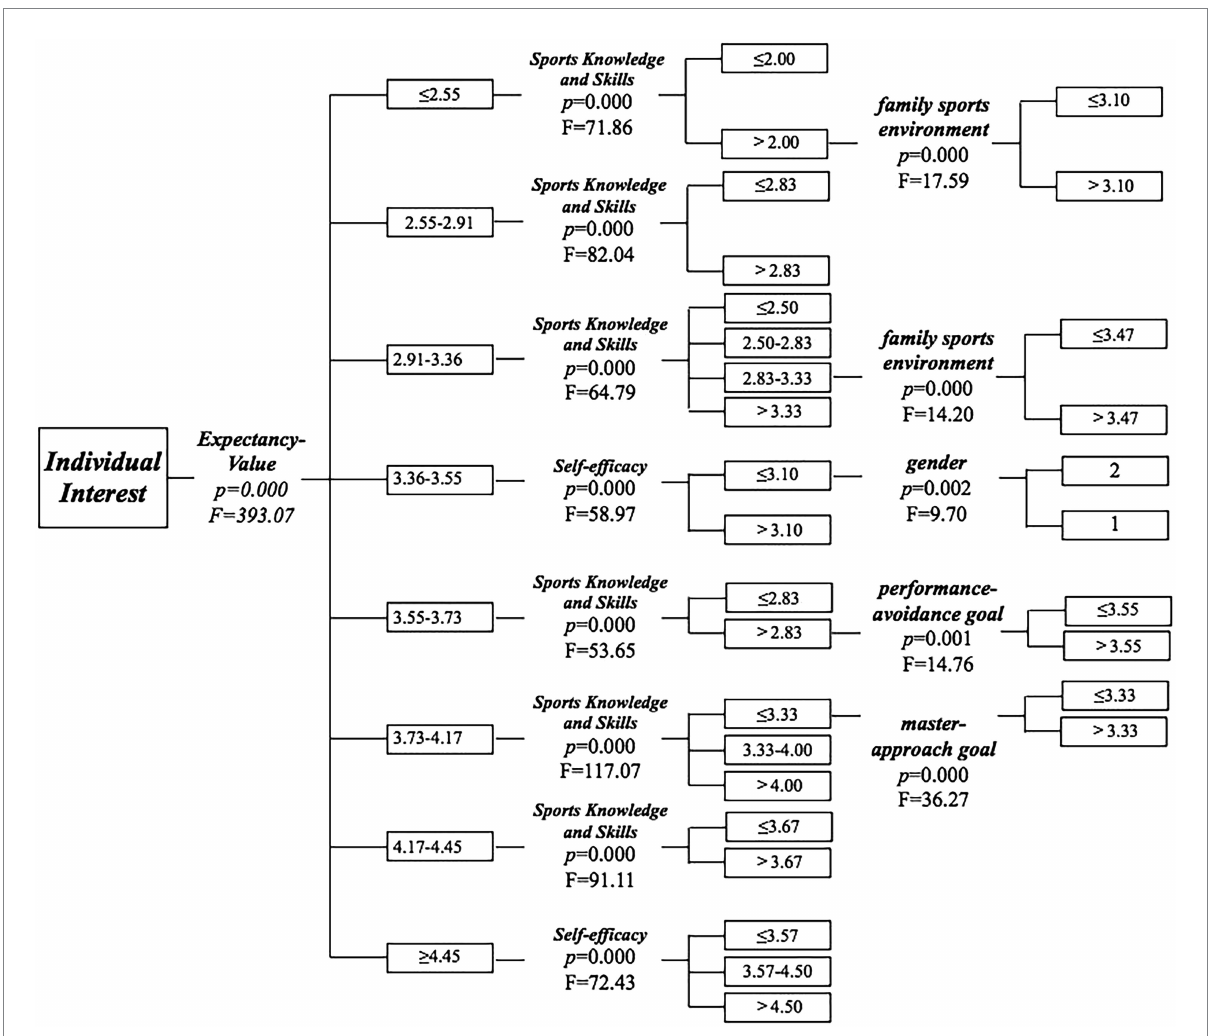
FIGURE 1 The decision tree model of the seven influencing factors, including expectancy-value, sports knowledge and skill mastery, self-efficacy, mastery- approach goal, family sports environment, performance–avoidance goal, and gender of individual interest. The asterisk indicates a statistically non-significant level of alpha. 05.